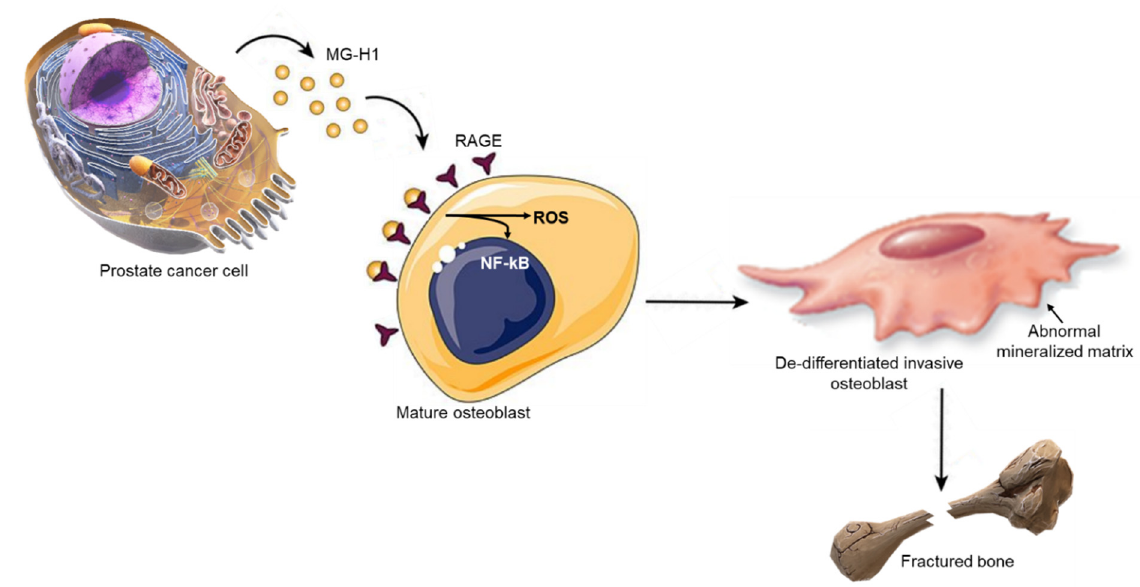
Figure 13. Metastatic prostate cancer (PCa) cells secrete methylglyoxal (MG)-derived 5-hydro-5-methylimidazolone (MG- H1) to reprogram human osteoblasts (OB) into a dedifferentiated, malignant-like phenotype: a possible novel player in prostate cancer bone metastases. MG-H1 released by PCa cells induces OB to dedifferentiate, assuming a spindle-shape morphology, reducing osteogenic differentiation markers, decreasing adhesive proteins, enhancing mesenchymal-like components and cell protrusions, acquiring motility properties. In addition, MG-H1 increased abnormal OB mineralization activity, leading to a bone structure with a markedly reduced mechanical strength and, consequently, more susceptible to pathological fractures. All these changes occurred via MG-H1 binding and activation of the receptor for advanced glycation end products (AGEs), RAGE. Hence, MG-H1 represents a novel player in the cross-talk between PCa cells and OB to create a favorable growth environment for bone metastases.